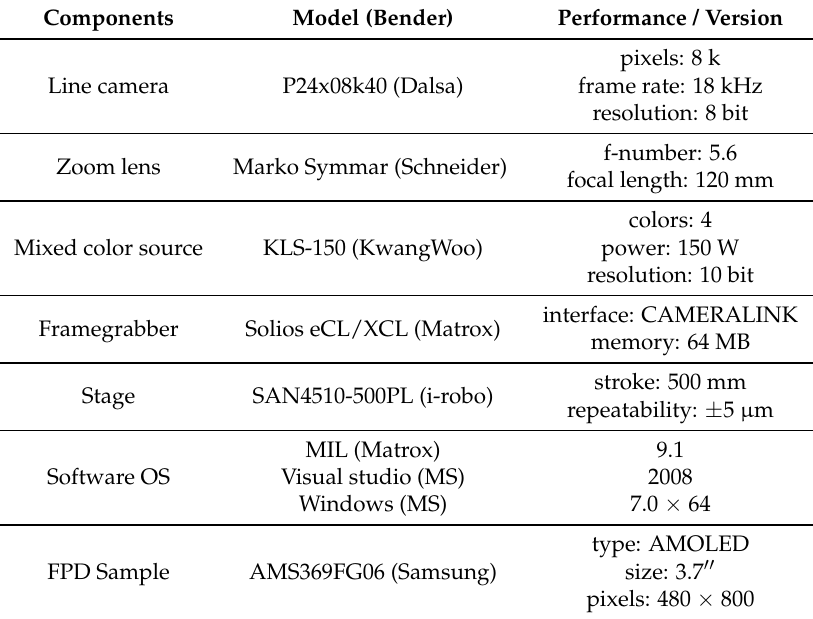
Table 1. Specifications of experimental setup.